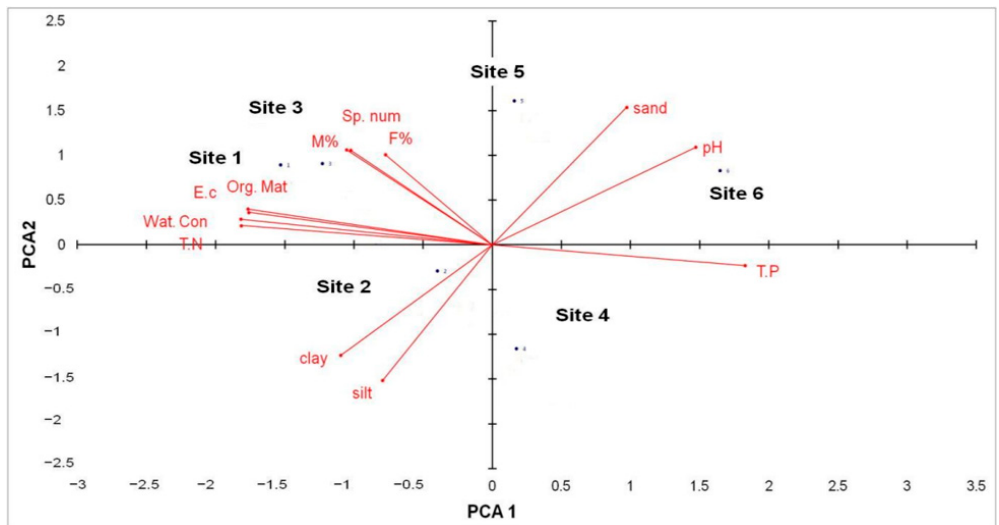
Figure 5. Results of a principal-component analysis (PCA) showing the relationships between soil properties and AMF parameters. E.c: electrical conductivity; T.N: total nitrogen; T.P: total phosphorus; Org. Mat: organic matter; Wat. Con: water content; Sp. num: number of spores; F%: mycorrhizal frequency; M%: mycorrhizal intensity.